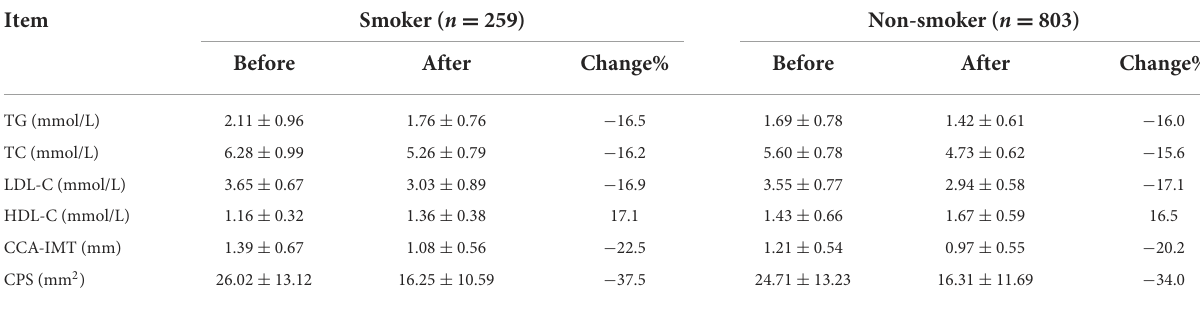
TABLE 9 Comparison of the effects of NK on lipid profile and atherosclerosis progression in smoking and nonsmoking participants.